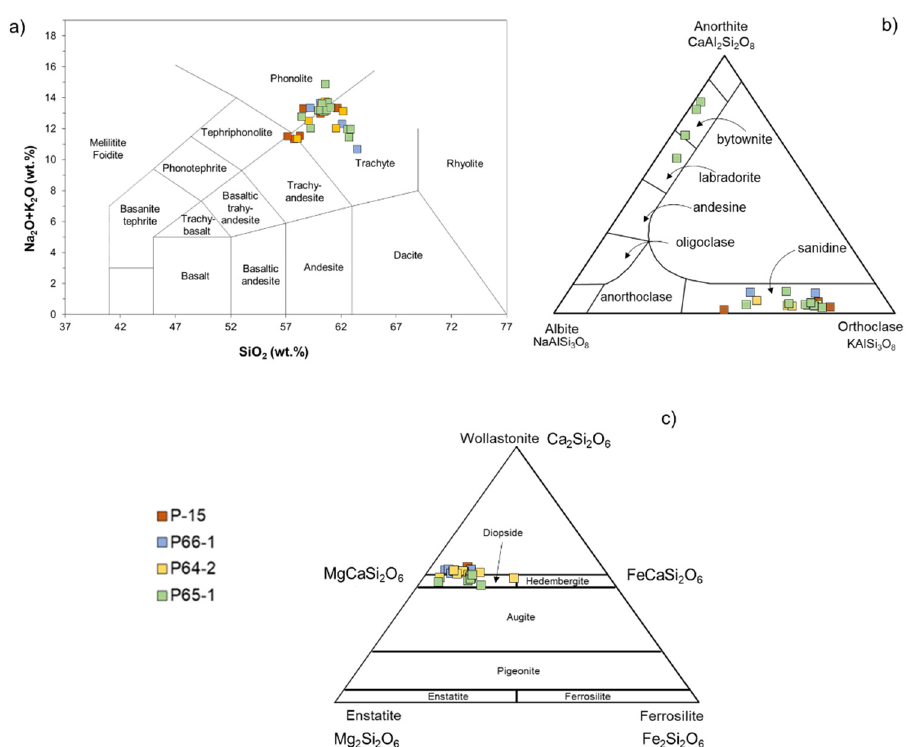
Figure 6. ( a ) Total alkali vs. silica [45] for glass analyses of juvenile products for the investigated mortars; ( b ) composition of the analyzed feldspars; ( c ) composition of the analyzed clinopyroxenes.